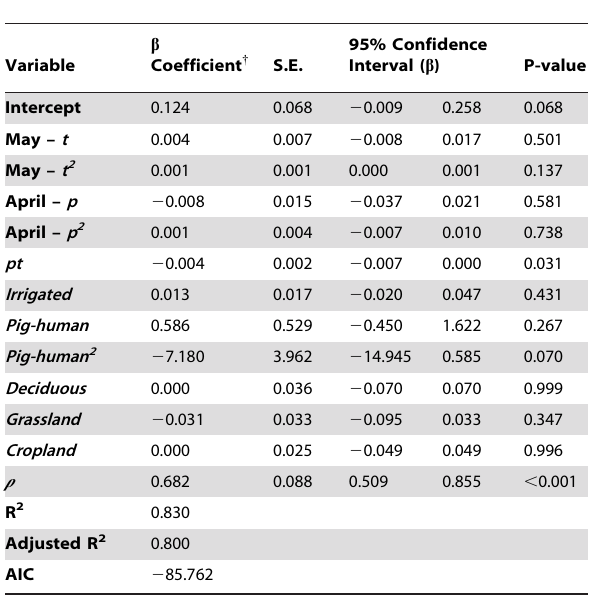
Table 3. Parsimonious model of 2005 district-level JE incidence as a function of climate, agriculture and land-use.